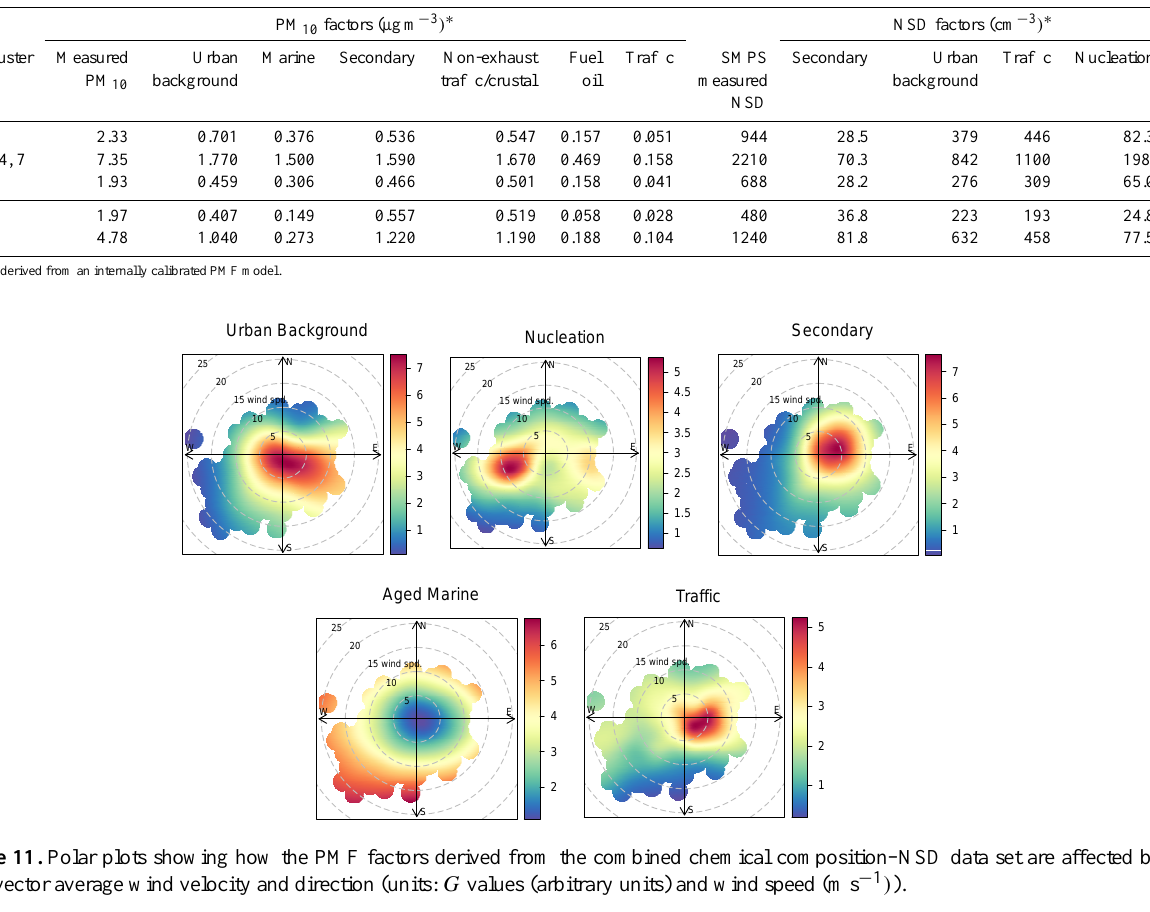
Table 6. Contribution from each factor from each trajectory cluster to the annual mean.